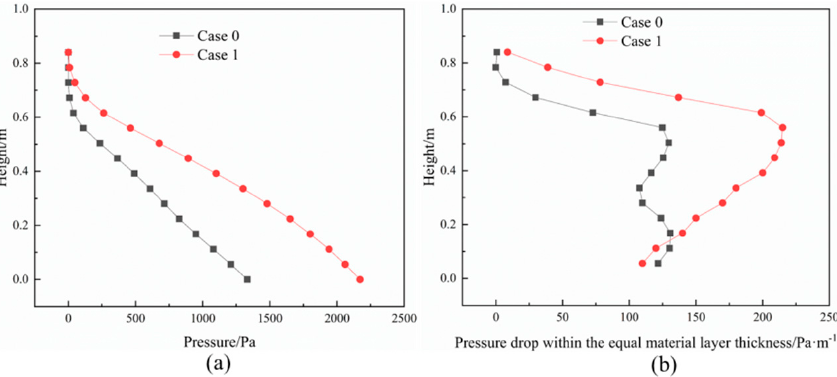
Figure 7. Cooling gas pressure and pressure drop distribution of equal thickness material layer. ( a ) Cooling gas pressure distribution; ( b ) pressure drop distribution of equal thickness material layer.